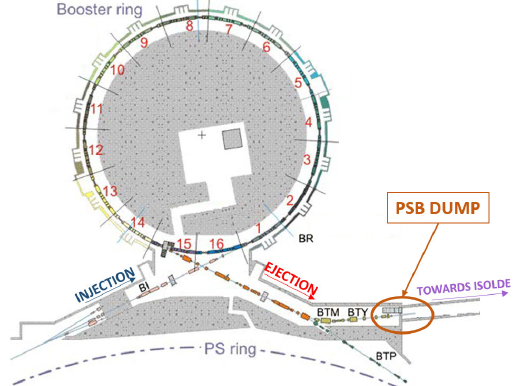
FIG. 2. Layout of the proton synchrotron booster (PSB). The PSB dump is located at the end of the BTM line, below the transfer line to the ISOLDE Facility and after the ejection line toward the proton synchrotron (PS).